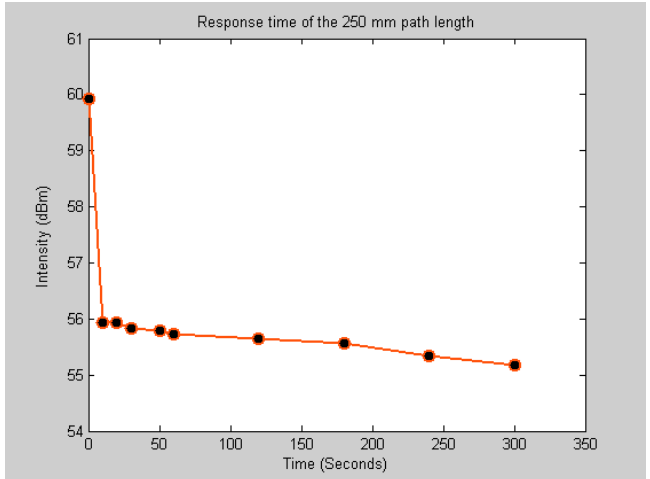
Figure 9. 250mm Path Length (134 µm bore size) Response